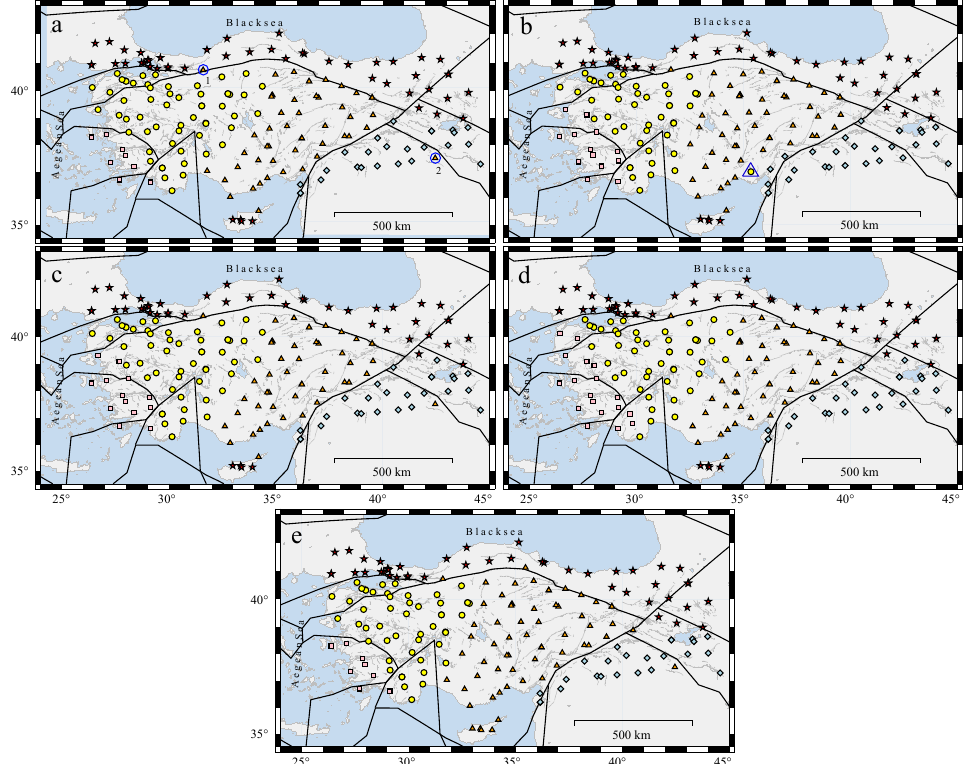
Figure 5. Turkey GPS-derived velocity clustering results for k = 5 clusters with: ( a ) BIRCH; ( b ) HAC; ( c ) k -means; ( d ) mini batch k -means; ( e ) spectral clustering algorithms. Black solid lines are the block model at [5]. Gray thin lines show active faults